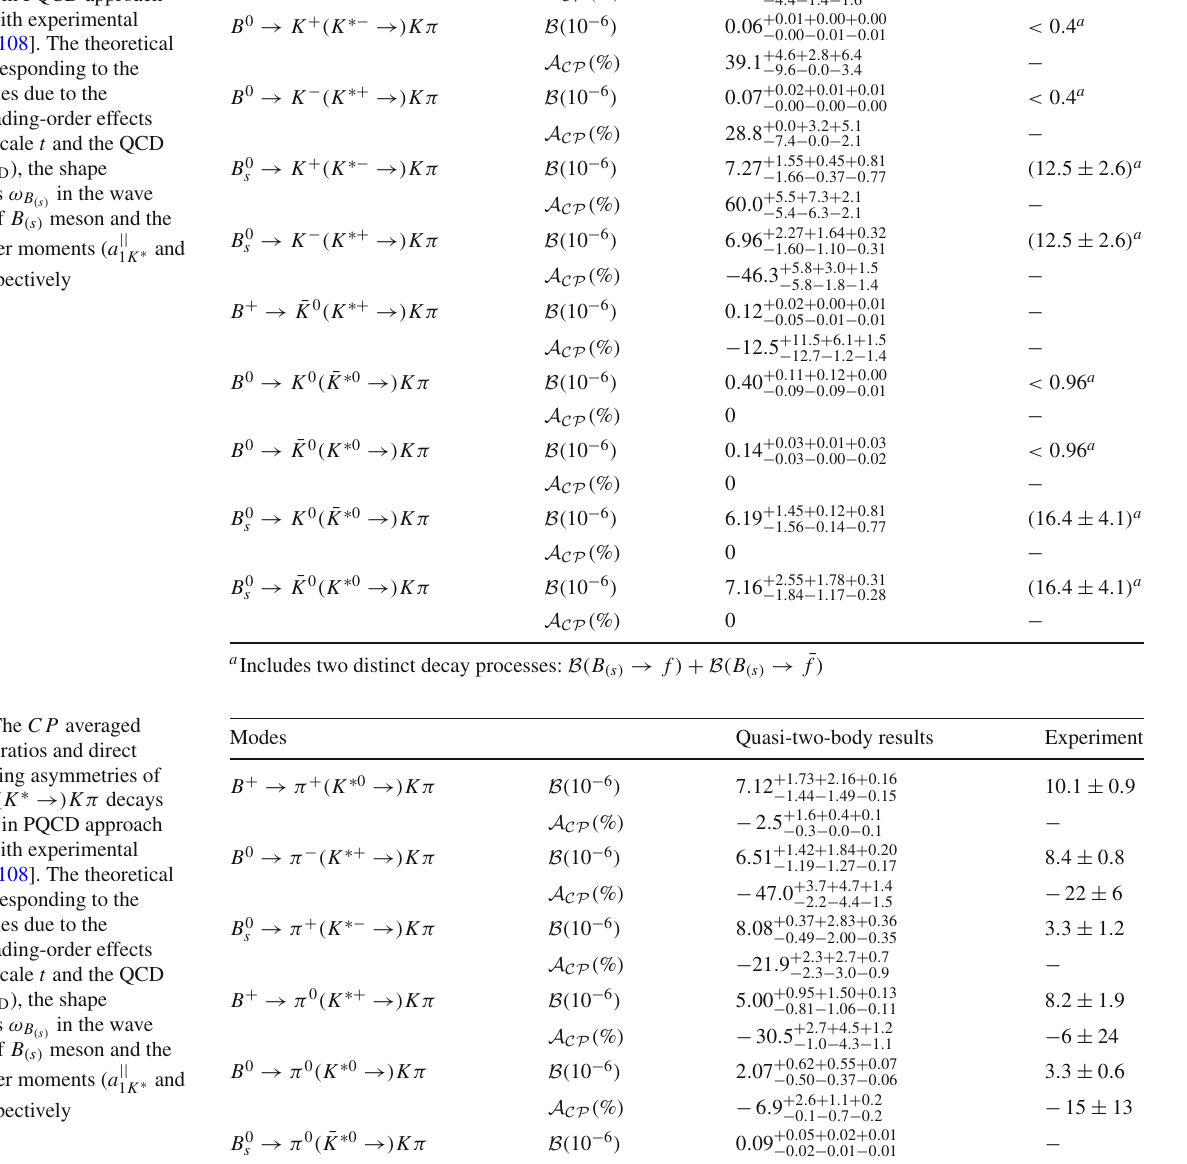
while the last one is less than 15%. The errors from τ B ± , τ τ B s and the Wolfenstein parameters in [107] are very small and have been || = 1 K ∗